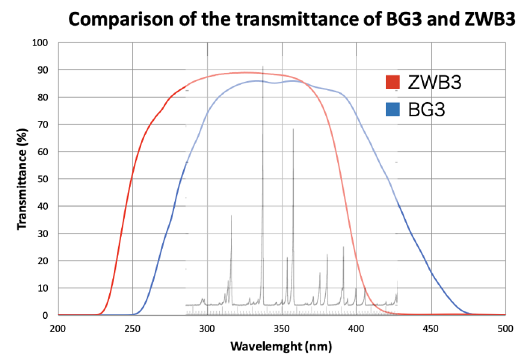
Figure 11. Transmittance of UV transmitting filter. ZWB3 is planed to be used for CRAFFT and BG3 is used for TA FD. Flu- orescence spectrum is superposed.